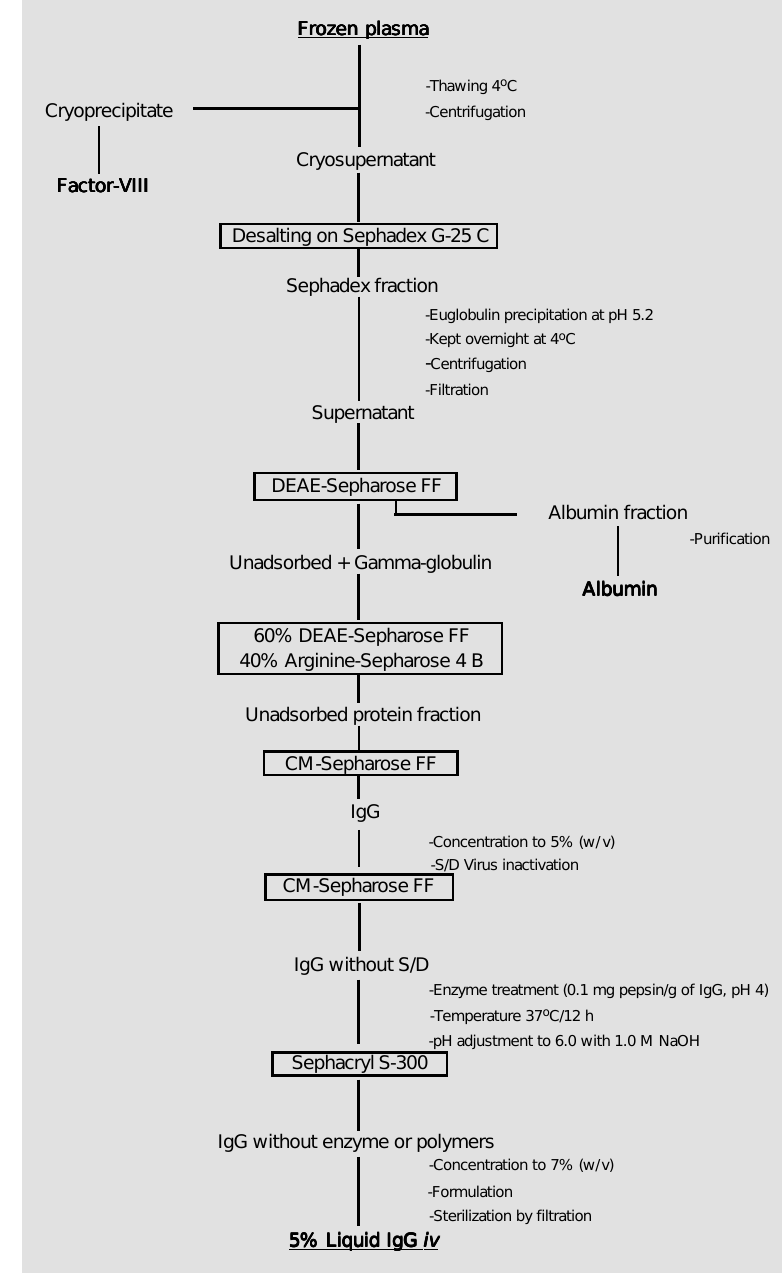
Figure 1 - Flow diagram for the production of liquid intravenous